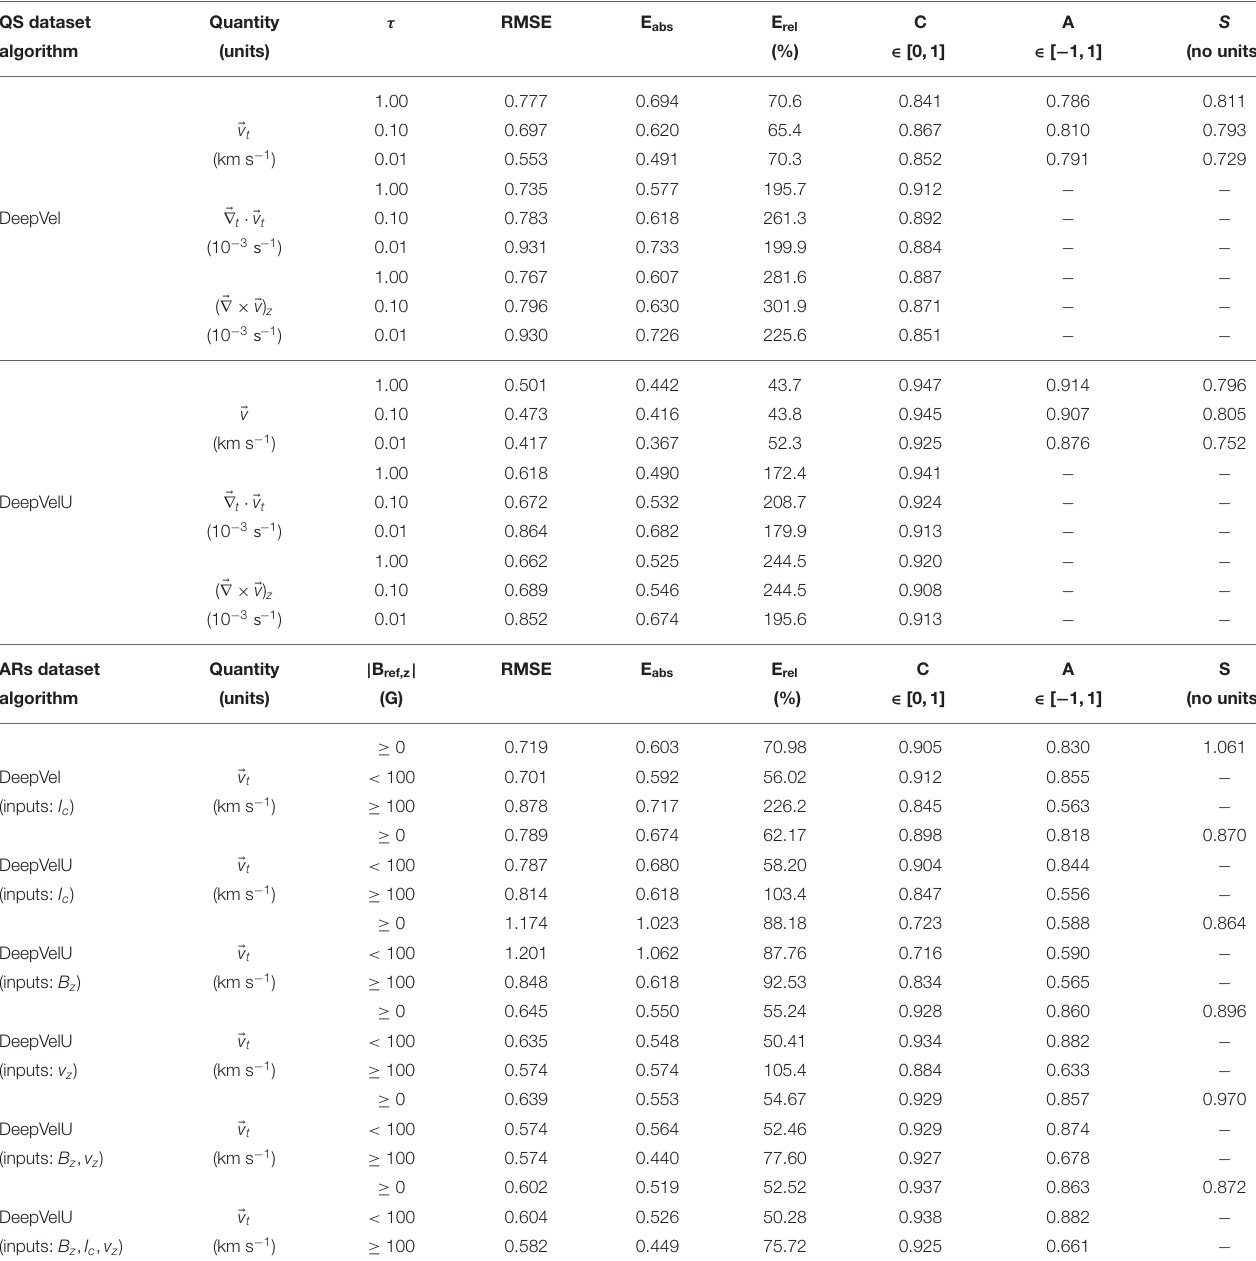
TABLE 1 | Comparison between the 30-timestep-averaged E v D, t and E v ref, t for the QS dataset and ARs